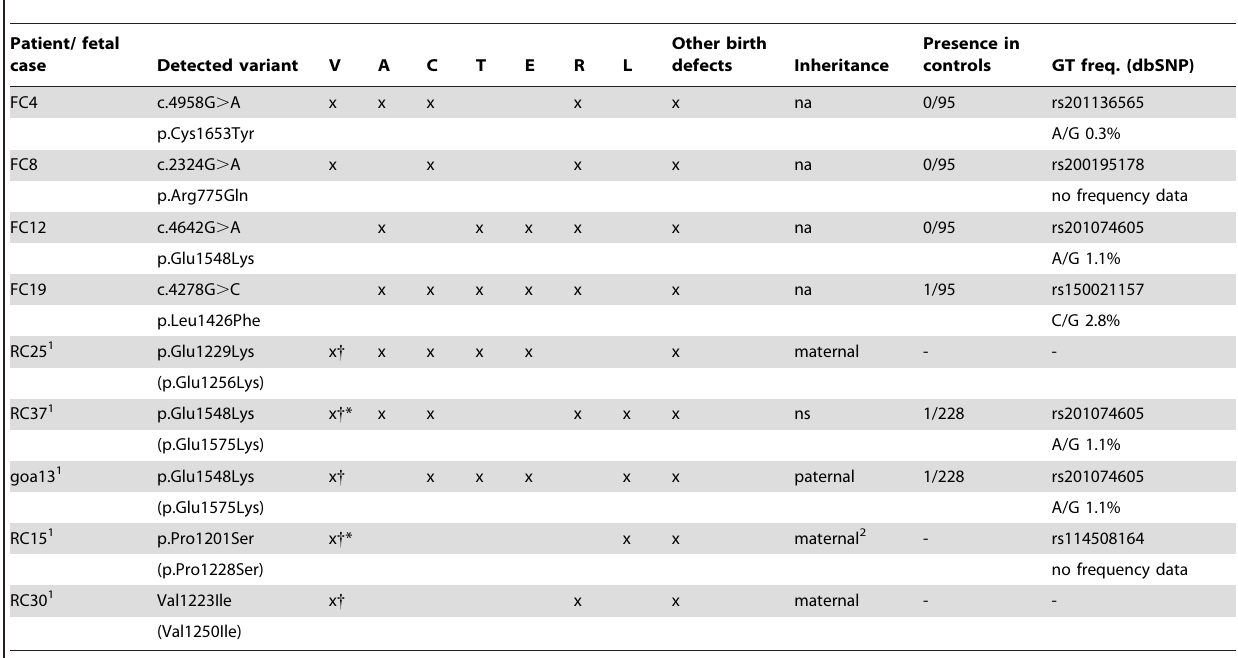
Table 3. PCSK5 variants and corresponding phenotypes in fetal cases with VACTERL association.